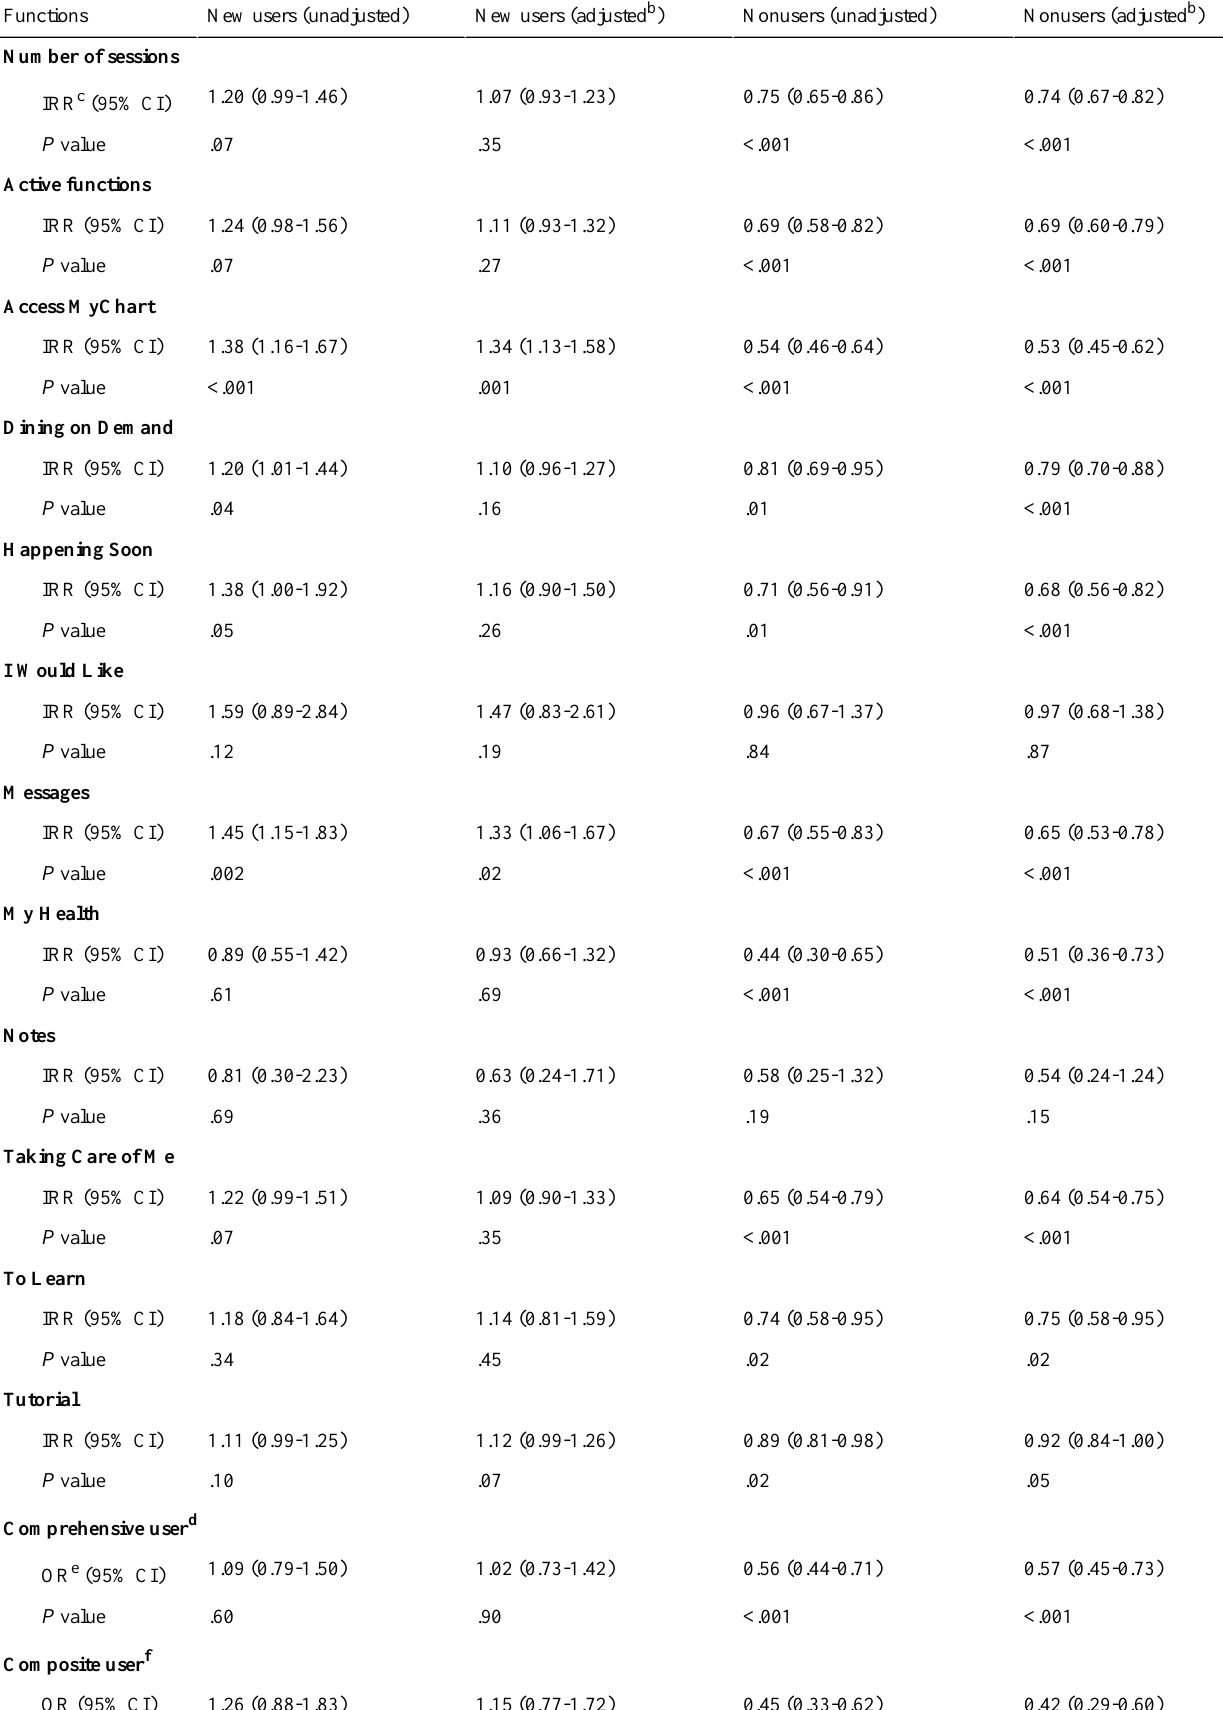
Table 3. MyChart Bedside function use in relation to MyChart user status (in reference to prior users) at the patient level a